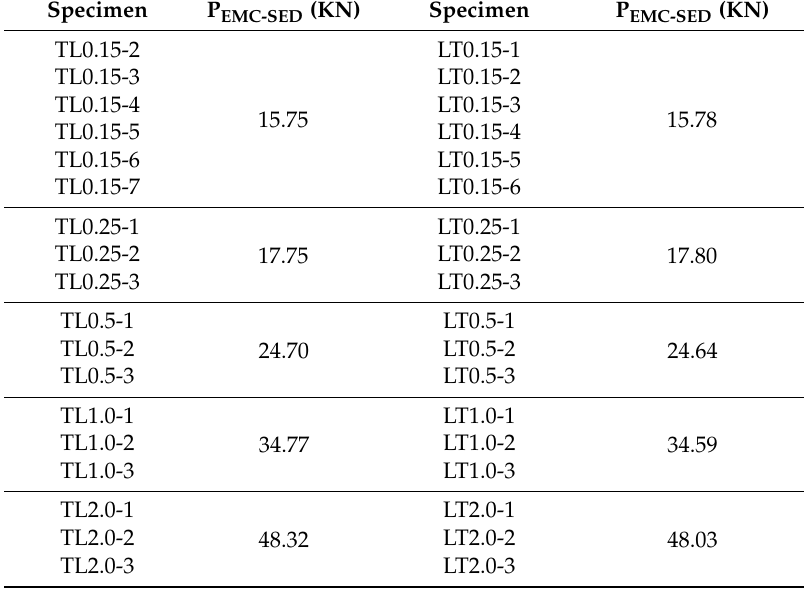
Table 8. Equivalent Material Concept-Strain Energy Density (EMC-SED) fracture loads for TL and LT